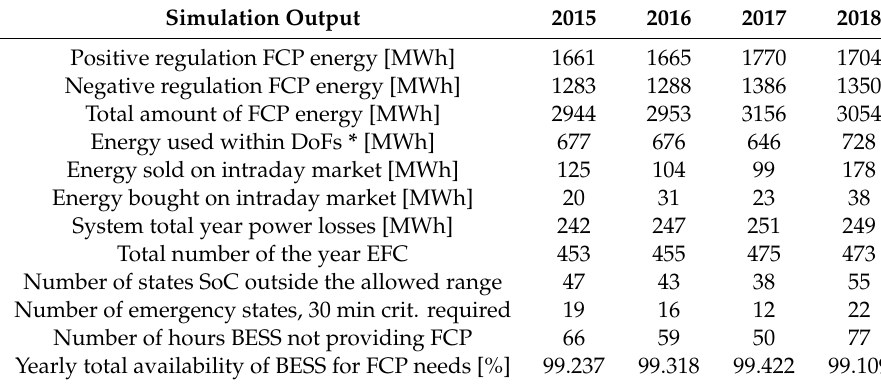
Table 6. Annual simulation outputs of BESS participating on providing FCR power reserves.